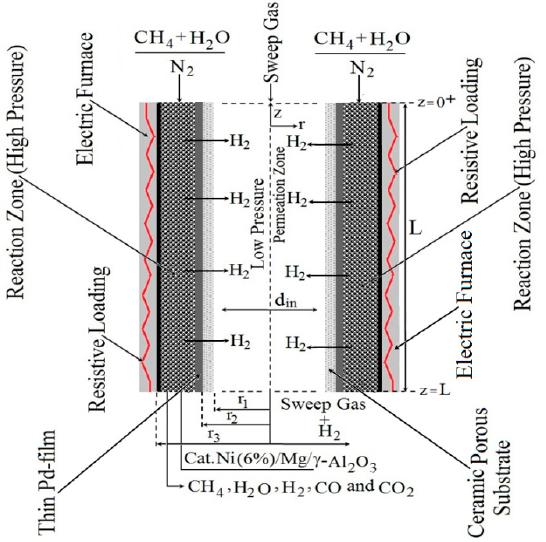
Figure 1. Schematic setup of the physical setup from Packed-Bed Membrane Reformer (PBMR) to study the Steam Reforming of Methane (SRM) method using electric heating.